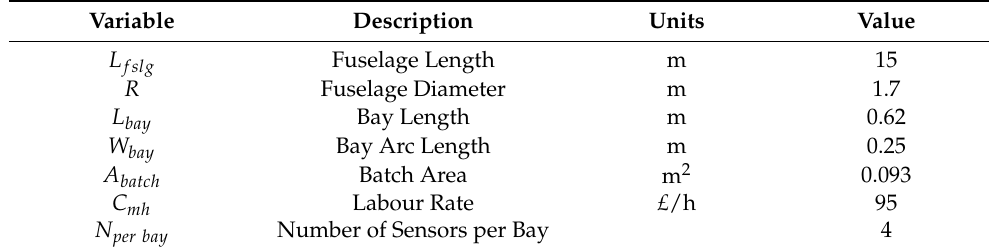
Table 1. Inputs for the regional aircraft